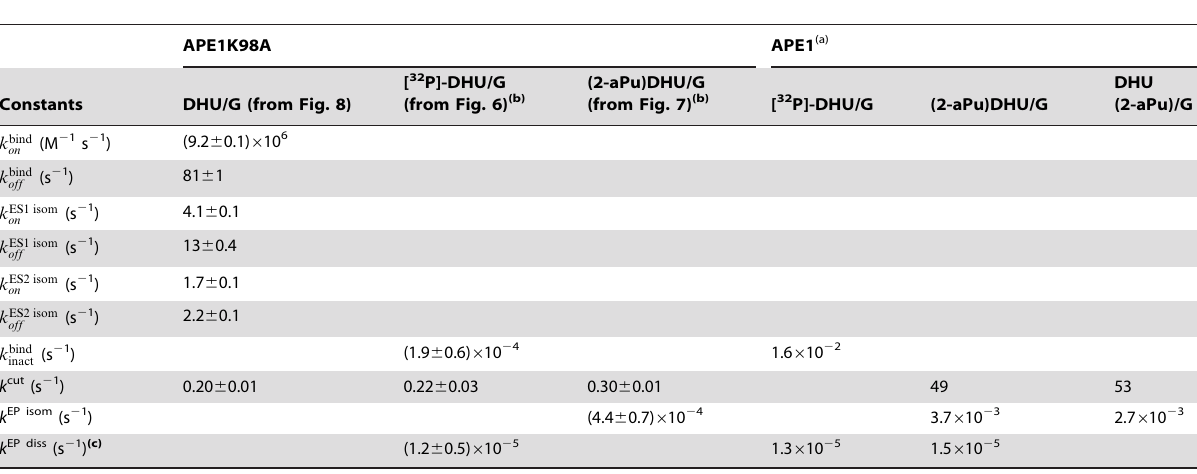
Table 3. Rate constants of APE1K98A and APE1 interactions with DHU-containing substrates in NIR